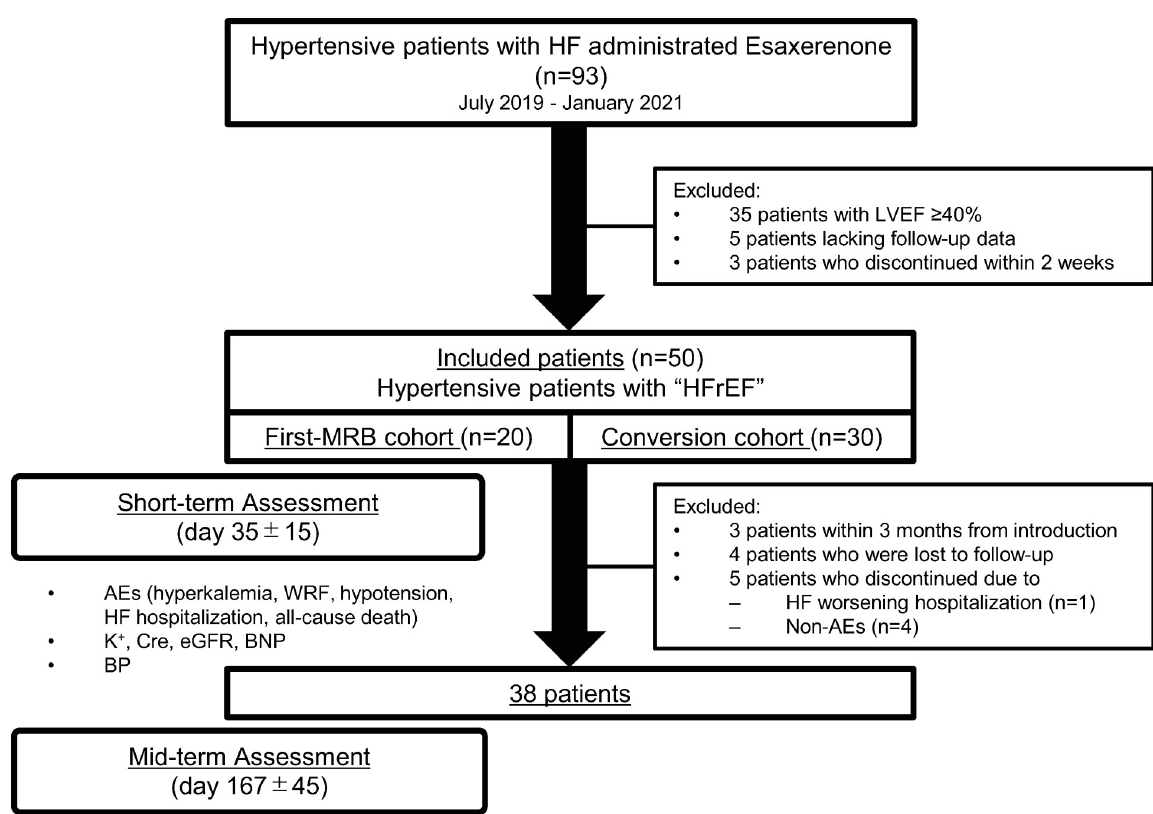
Fig 1. Study protocol. The first-MRB cohort was defined as patients who have not been treated with other MRBs. The conversion cohort was defined as patients who were converted from another MRB. HFrEF, heart failure with reduced ejection fraction; LVEF, left ventricular ejection fraction; MRB, mineralocorticoid receptor blocker; WRF, worsening of renal function; K + , serum potassium; Cre, serum creatinine; eGFR, estimated glomerular filtration rate; BNP, brain natriuretic peptide; BP, blood pressure; AE, adverse